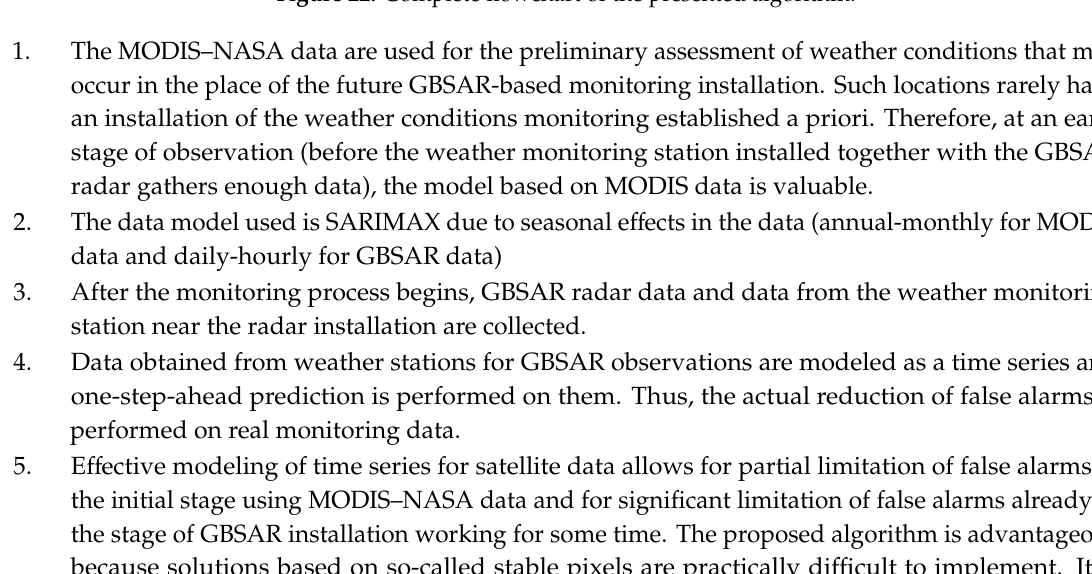
Figure 22. Complete flowchart of the presented algorithm.